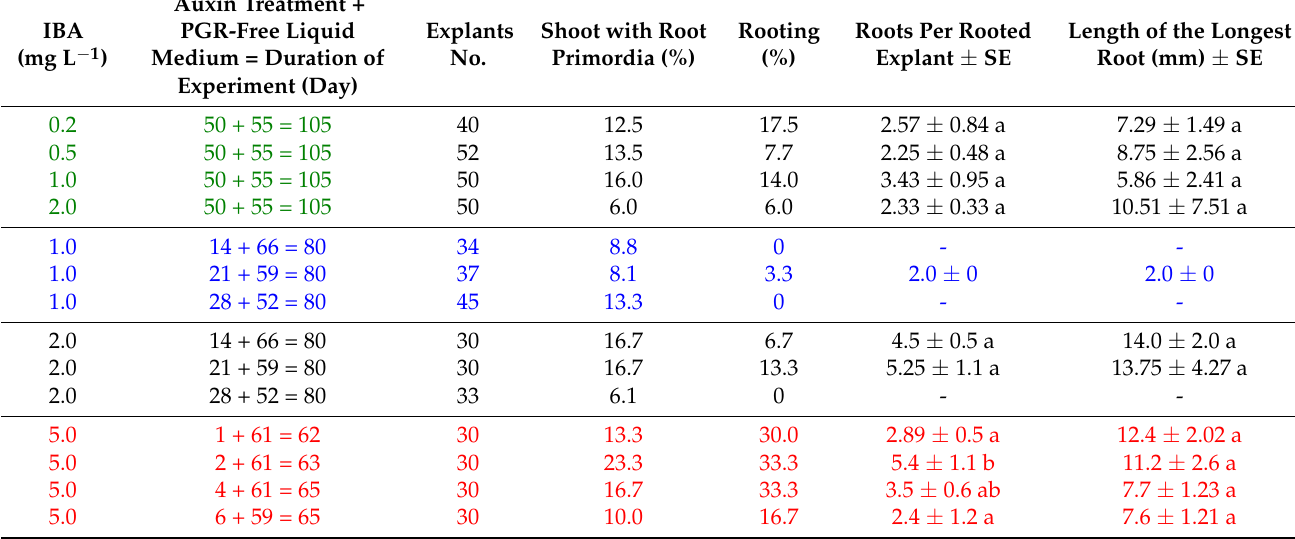
Table 3. Effect of pretreatments with IBA on the rooting of shoots of G. lutescens line 5. After IBA treatment the shoots were cultivated in liquid PGR-free 1 ⁄ 2 MS medium with 2% sucrose and fresh medium was added every 7 days. Experiments were repeated 2 times with 15–26 shoots per treatment ( n = 30–52). Within each group of experiments (distinct color) means followed by different letters in the column are significantly different according to Fisher’s LSD test at p ≤ 0.05. SE—standard